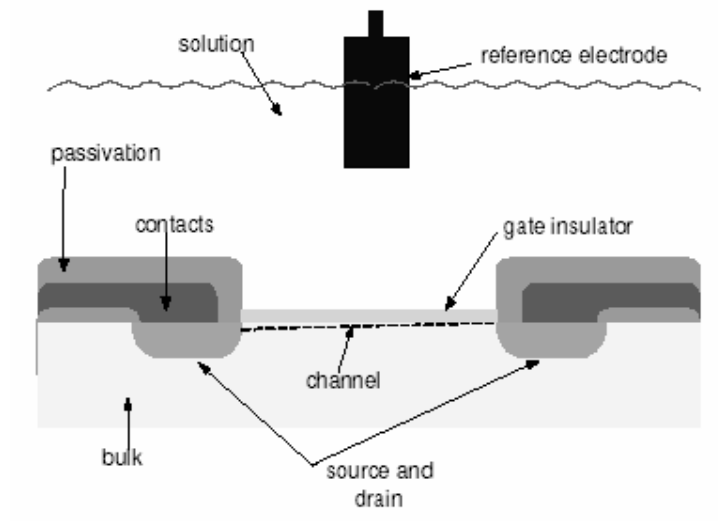
Figure 1. Cross-section of an ISFET structure. (Source: Janicki, M., Daniel, M., Napieralski, A.: Parameter Extraction for Electro-chemical Simulations of Ion-Sensitive Transistors . 10th International Conference Mixed Design of Integrated Circuits and Systems MIXDES 2003, Lodz, Poland, 2003 ; pp.